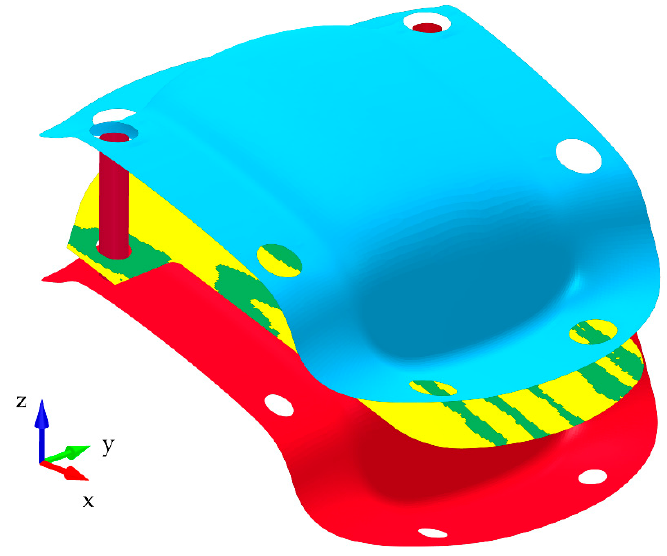
Figure 6. FE model of the forming simulation.